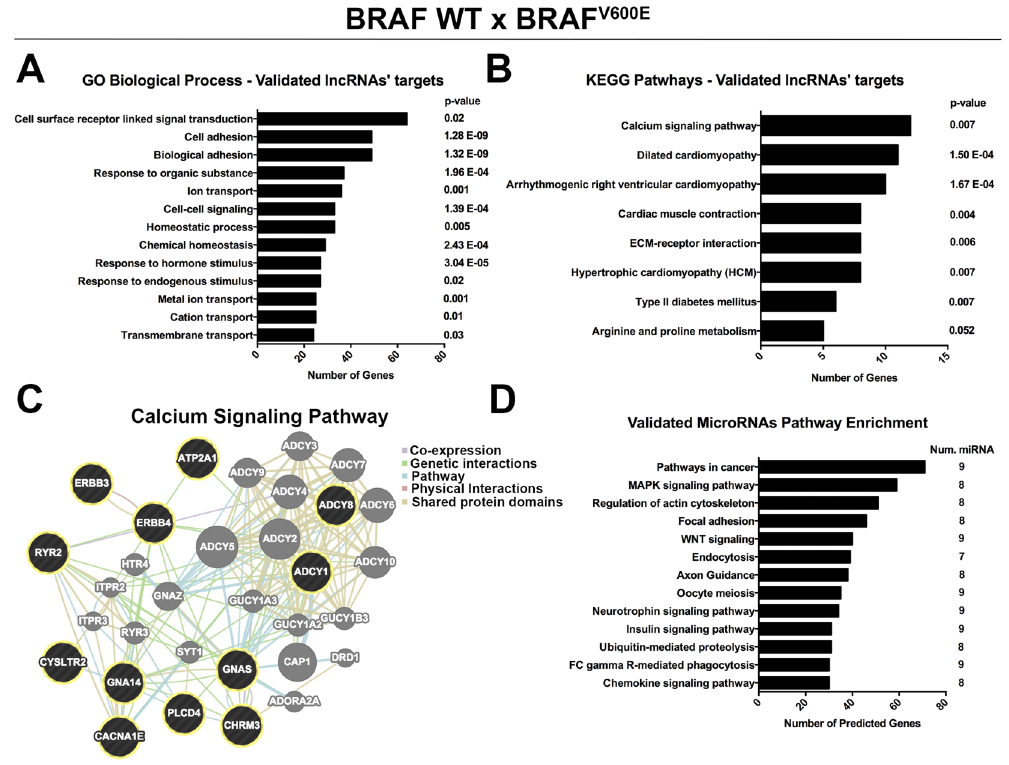
Figure 4. Indirectly validated targets of the DE lncRNAs between WT × BRAF V600E are involved in oncogenic pathways. ( A ) GO biological processes and ( B ) KEGG enriched pathways of the indirectly validated mRNA targets of the DE lncRNAs between WT × BRAF V600E . ( C ) Proteins’ network of genes linked to calcium signaling pathway, where black circles are validated targets and grey circles are connective proteins. ( D ) KEGG pathways enrichment of the indirectly validated microRNAs targets of the DE lncRNAs between WT × BRAF V600E .